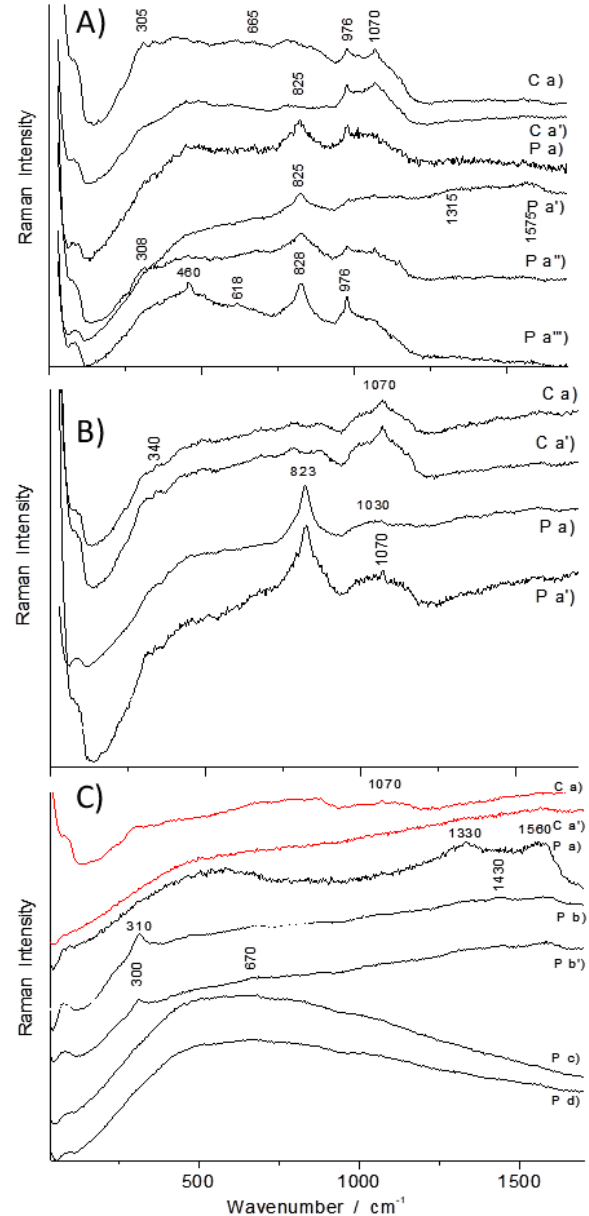
Figure 8. Representative Raman spectra recorded on the F1467.1 and F1467.2 ewers: ( A ) blue cloisonné (C) and painted (P) enamelled areas; ( B ) white cloisonné (C) and painted (P) areas; ( C ) black cloisonné (Ca,Ca’) and painted (Pa,Pb,Pb’) and pink painted (Pc,Pd) areas. Spectra obtained on dark to black areas with very short counting times (a few seconds, ( A ) Pa, ( B ) Pa’ and ( C ) Pa) are compared with those obtained with standard recording times to demonstrate the absence of degradation).